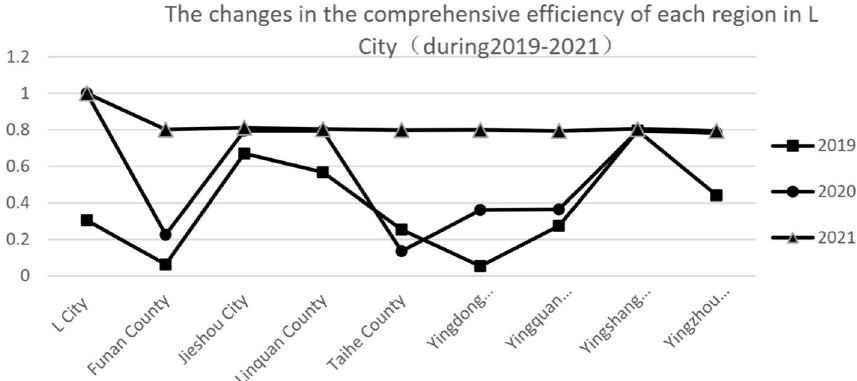
Fig. 1 The changes in the comprehensive efficiency of each region